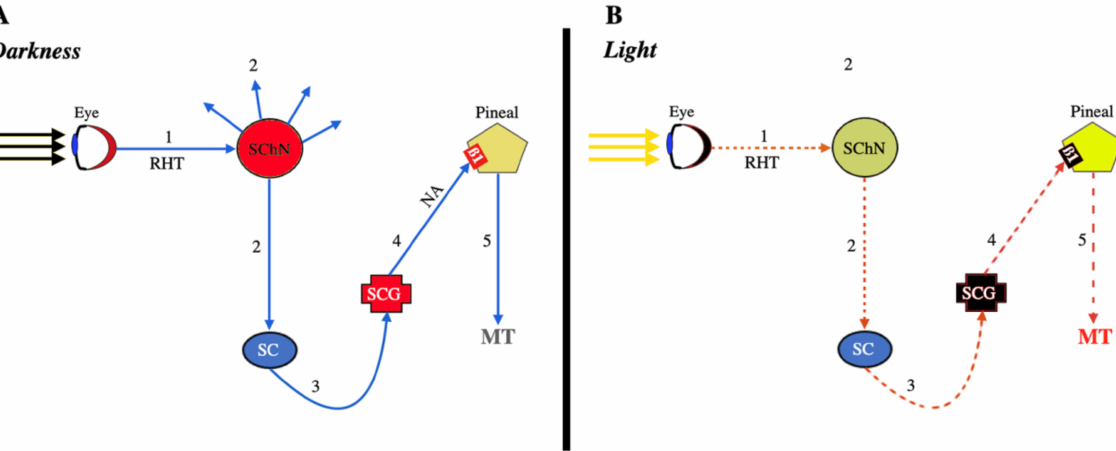
Figure 1. Signals involved in the production of MT by the pineal gland. ( A ): In the dark, the absence of light stimulation of the retina (red color) translates into signals (1) that stimulate the suprachiasmatic nucleus (SChN, red color) through the retino-hypothalamic tract (RHT). This nucleus then begins to send stimulating signals to different parts of the brain (2, blue arrows), but also a descending stimulating signal (2) to the spinal cord (SC, blue sphere), and from here to the adjacent sympathetic chain (3). These sympathetic signals reach the superior cervical ganglion (SCG), which is stimulated (red color) and sends stimulating signals (4) to the pineal, mediated by norepinephrine (NA) that interacts with a ß1-receptor in that gland (and also an α -adrenergic receptor, not shown), inducing the mitochondrial synthesis and release of MT (5). ( B ): In the presence of light, all the stimulating signals described above are interrupted (dotted red lines), and the superior cervical ganglion does not release NA; thus, the synthesis and secretion of MT are